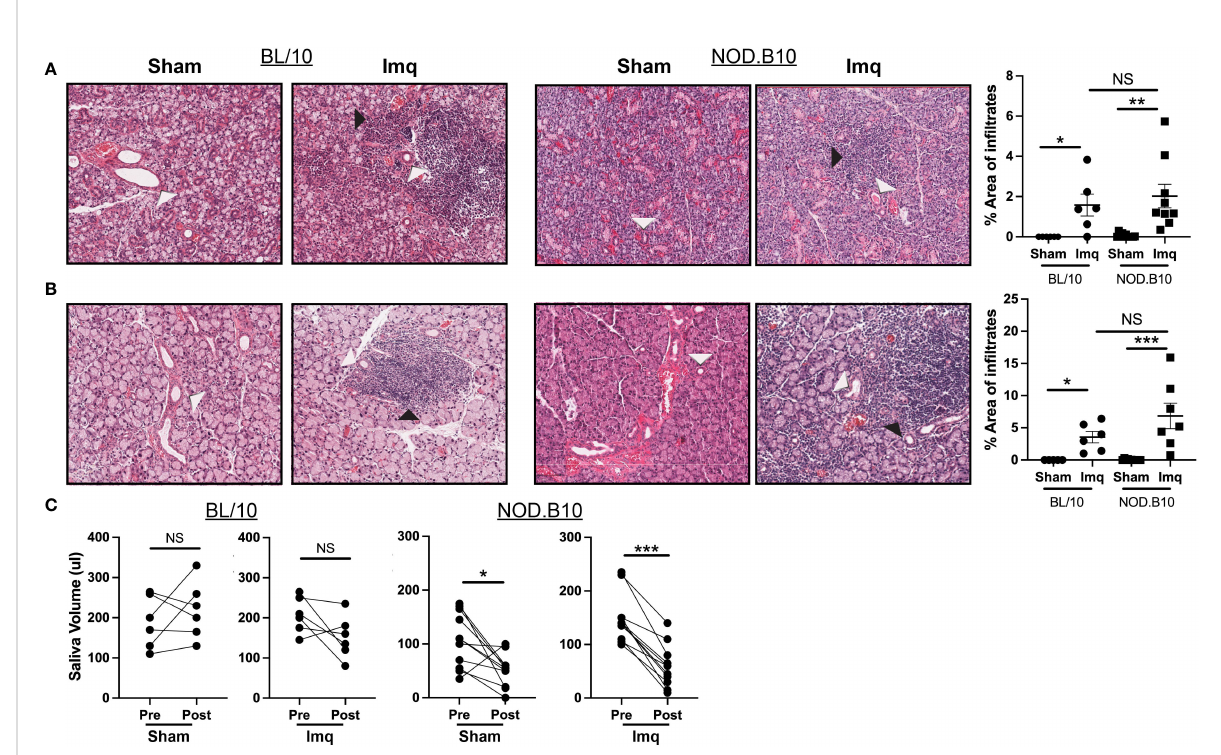
FIGURE 2 pSS mice treated with Imq exhibit robust lymphocytic in fi ltration of exocrine tissues and loss of salivary fl ow. (A) SMG and (B) lacrimal tissues were harvested from sham (n = 10) or Imq-treated female mice (n = 9) and from sham (n = 6) or Imq-treated age and sex-matched controls (n = 6). One representative photomicrograph is shown from each group. White arrows indicate exocrine gland ducts and black arrows indicate in fl ammation. Lymphocytic in fi ltration was quanti fi ed using ImageJ. Horizontal lines represent the mean and SEM (C) Stimulated saliva was collected prior to treatment and at the conclusion of the experiment from BL/10 and NOD.B10 mice. (NS = non-signi fi cant, *p < 0.05, **p < 0.001, ***p <